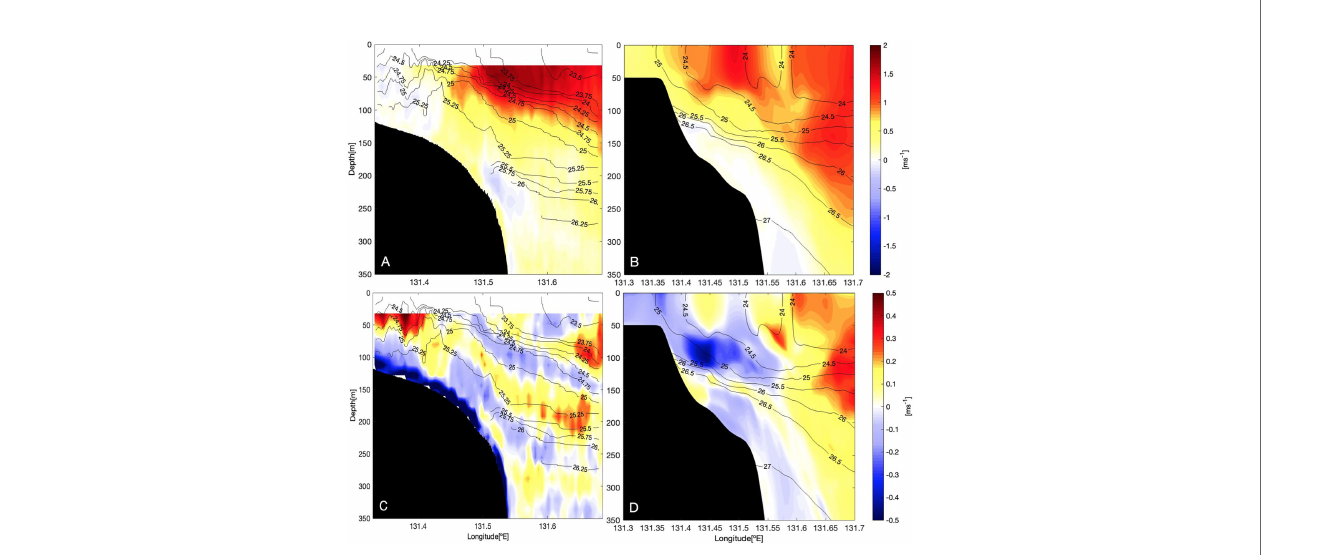
FIGURE 4 | Vertical sections of (A, B) along and (C, D) across-frontal velocities (ms -1 ). (A, C) are from in-situ observations taken onboard in November 2018 (Nagai et al., 2019); (B, D) are from ROMS numerical simulation on December 20 th at hour 08:00. Positive velocity indicates the fl ow toward the Kuroshio downstream in (A, B) and toward offshore in (C, D) . The black contours represent isopycnals. Note there are marked differences in the density structures at 50-100 m between isopycnals s q = 24.5 and 25 kg m -3 after 10 hours that are shown in Figure 3 , illustrating how rapidly the hydrographic structures change over